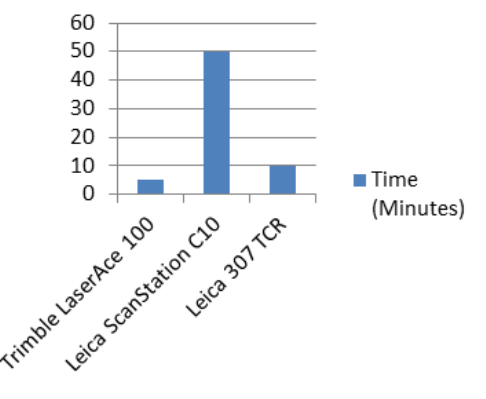
Figure 3: Time of data collection and 3D building modeling i.